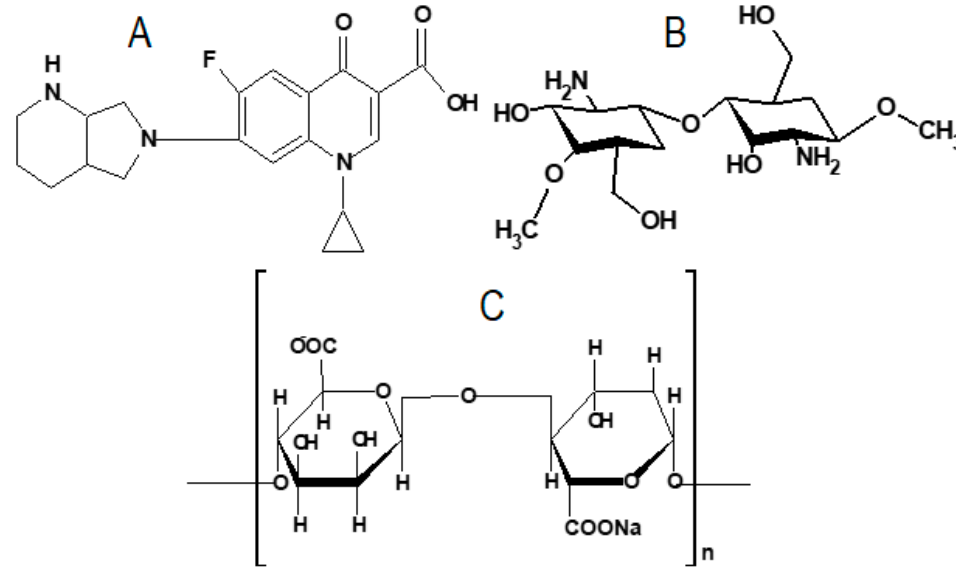
Figure 1. Chemical structures of ( A ) moxifloxacin, ( B ) chitosan, and ( C ) sodium